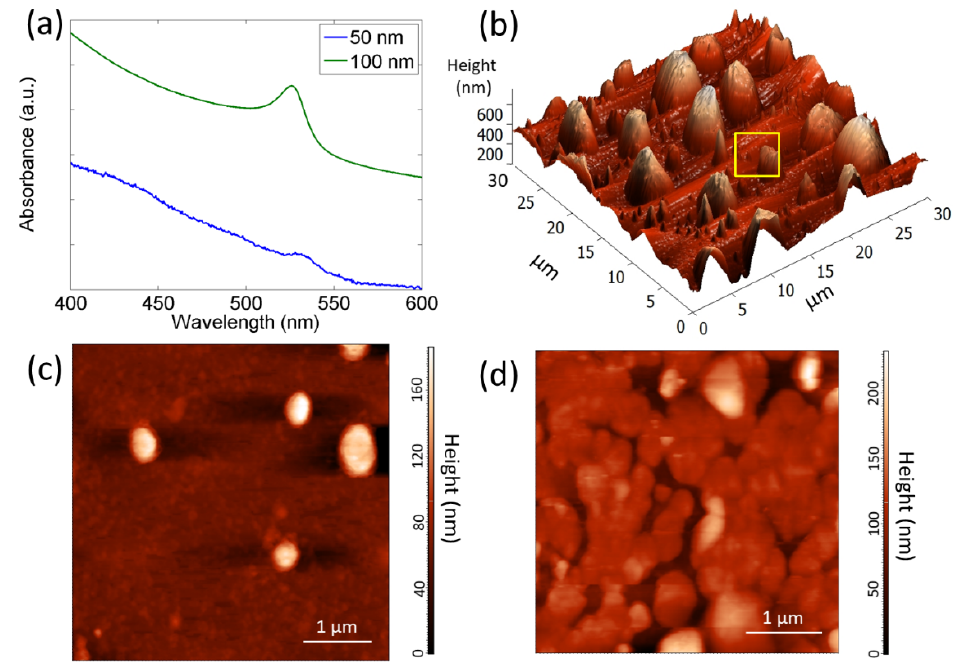
Figure 1. ( a ) Absorbance spectra (in a.u.) of the perovskite thin films with nominal thickness of 50 nm (sample A) and 100 nm (sample B). In order to distinguish the two spectra, that of sample B is up-shifted along the y -axis; ( b , c ) AFM images of sample A and ( d ) sample B. Panel c shows a detail of the bottom layer of sample A, marked by the yellow square in panel